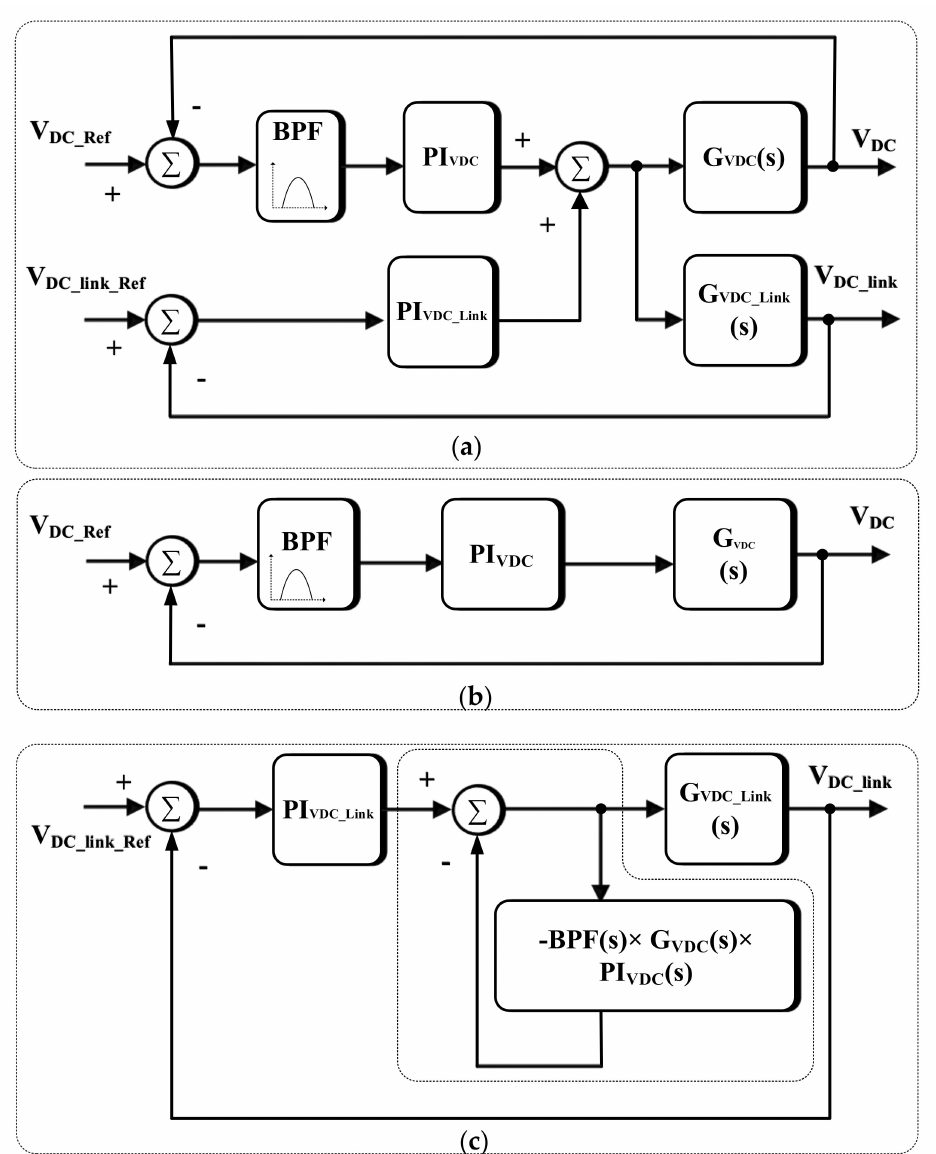
Figure 8. Control block diagrams: ( a ) proposed DAB converter control; ( b ) double line frequency ripple elimination loop; ( c ) DC link voltage control with the double line frequency ripple